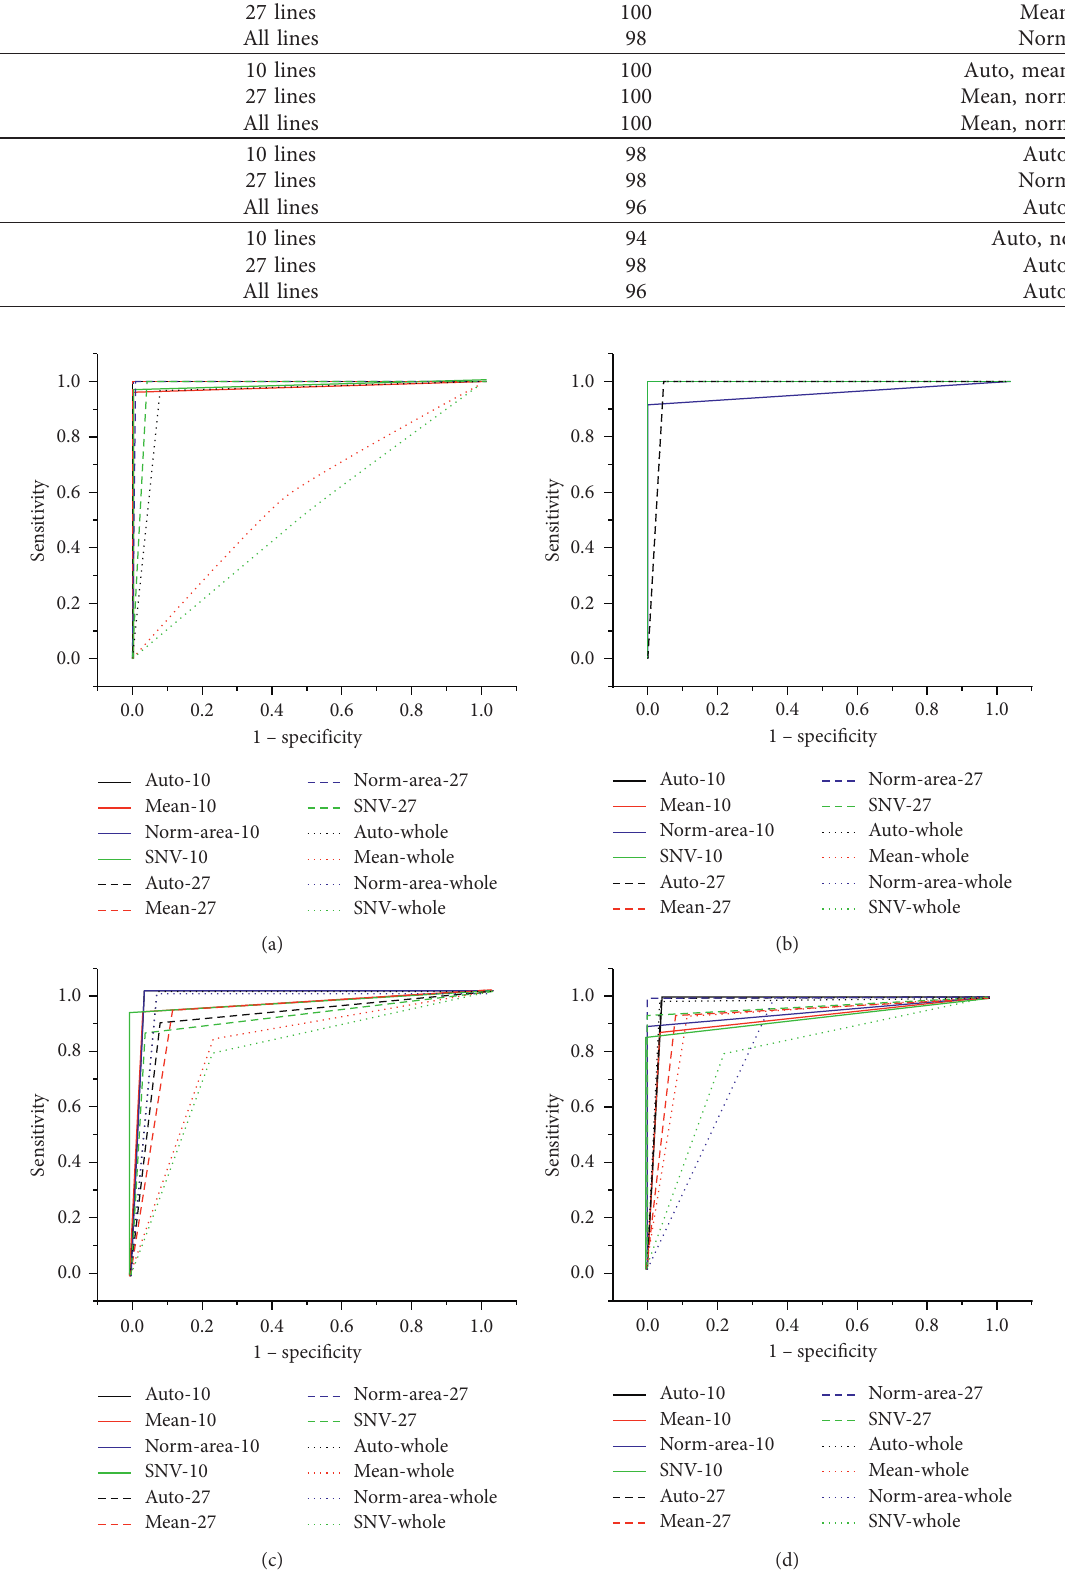
Figure 7: ROC curves of the (a) ANN model of 10-line input variable (solid line), 27-line (dash line), and the whole spectra (dot line) input data and different preprocessing methods; (b) PLS-DA; (c) LDA; and (d) QDA models showed the sensitivity and specificity,